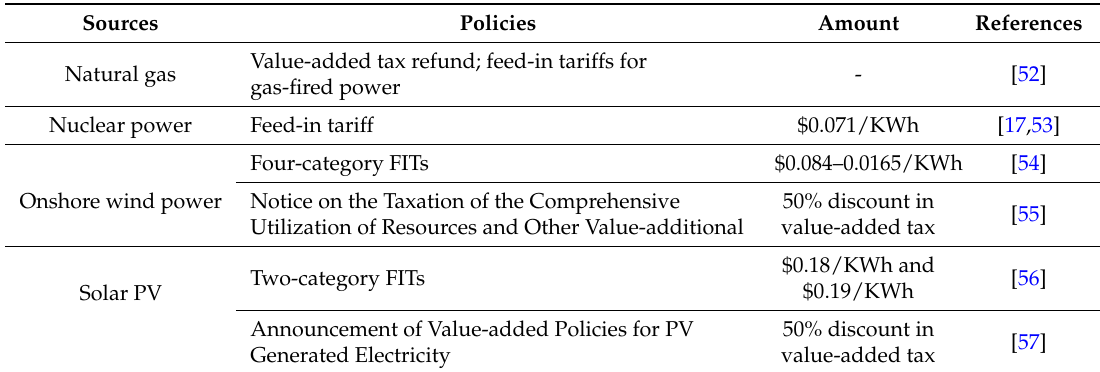
Table 4. Finance and taxation policies that promote cleaner energy use in the power